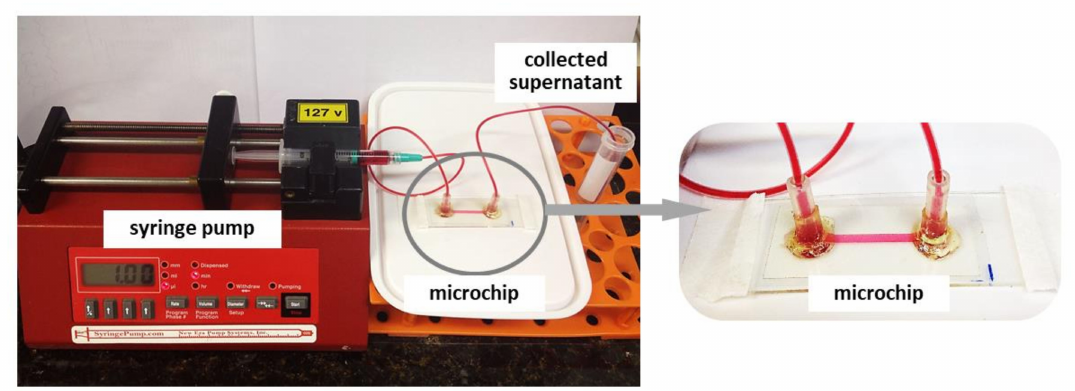
Figure 3. Schematics of the experimental setup of the dynamic microchip system. After cell adhesion to the microchannel for 4 h under static conditions in the incubator (a crucial point in the cells’ ability to resist the subsequent shear stress), the microchip was connected to a syringe pump. The microchip was perfused at a continuous unidirectional flow rate of 2 µ L min − 1 with RPMI-1640 culture medium. A Teflon tubing connected the syringe pump and the microchip through a female luer adapter. The supernatant exited on the opposite access and collected into a sterile Falcon ® tube sealed with plastic film (Parafilm ® “M”–Laboratory Film). The system was kept in the incubator at 37 ◦ C at 5% CO 2 during the